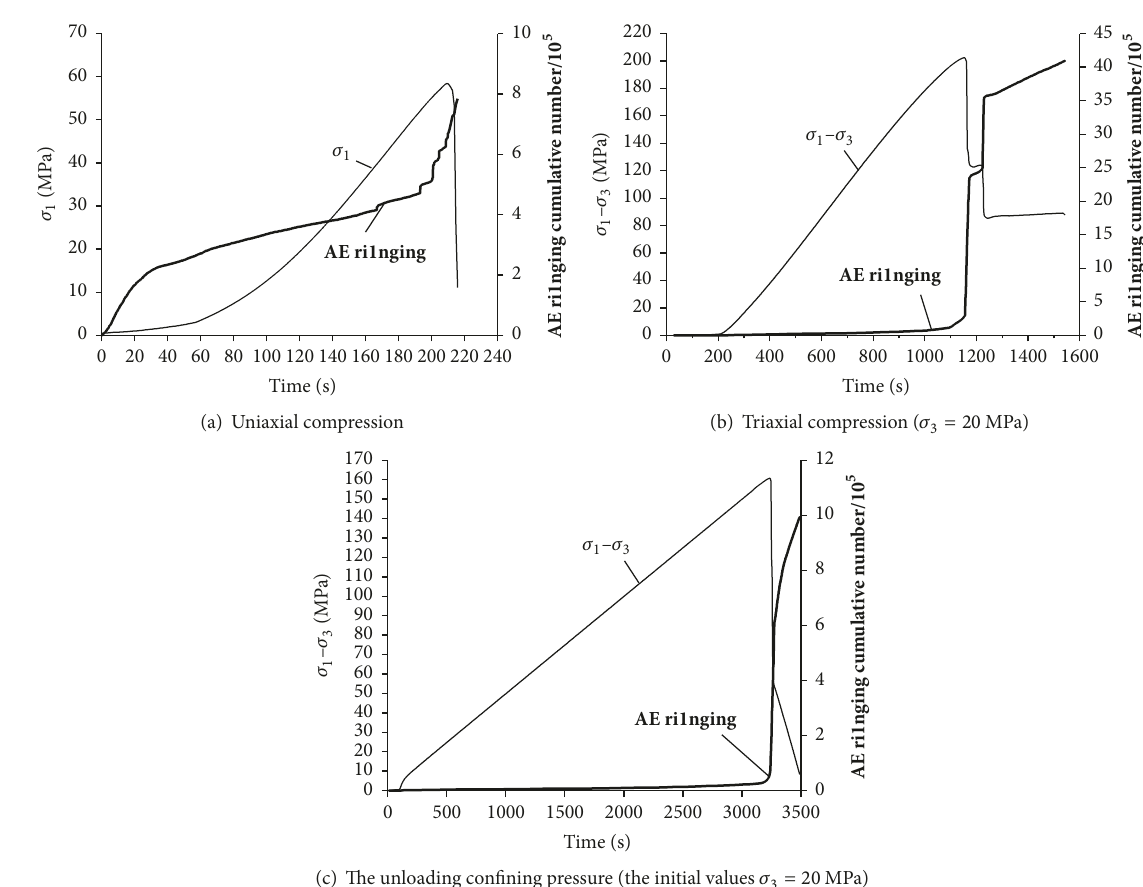
Figure 9: Test results of AE accumulative ringing of rock specimens under different stress paths.